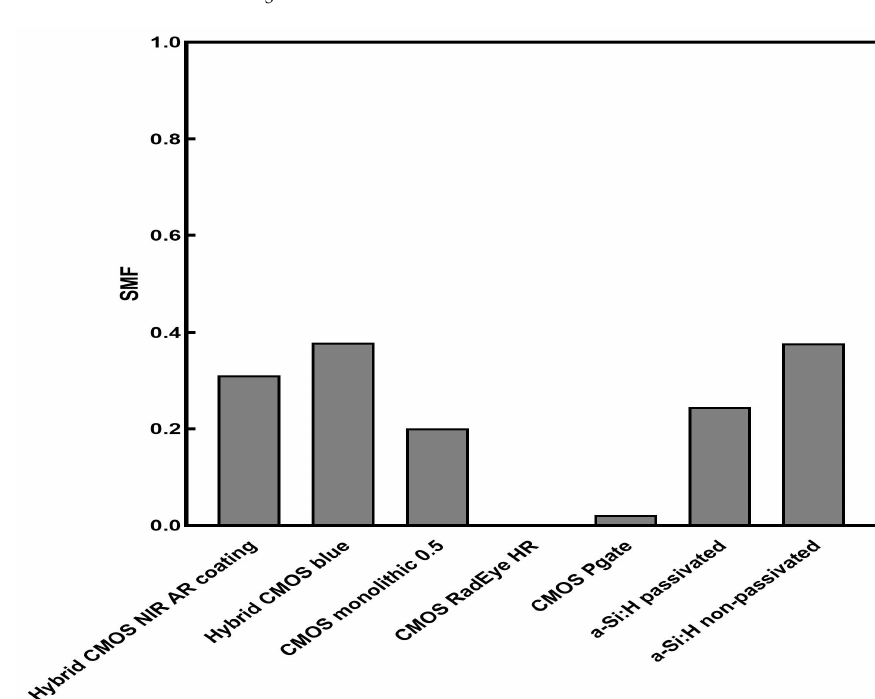
Figure 12. SMF values of LaBr 3 :Ce with various CMOS.